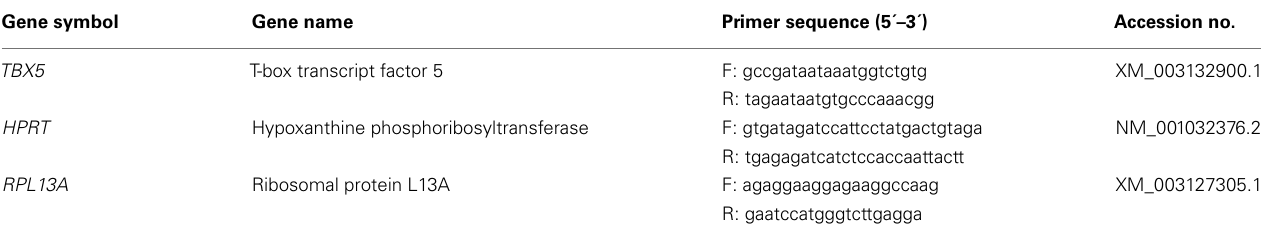
Table 1 | Primers used for quantitative real-time polymerase chain reaction (qPCR).